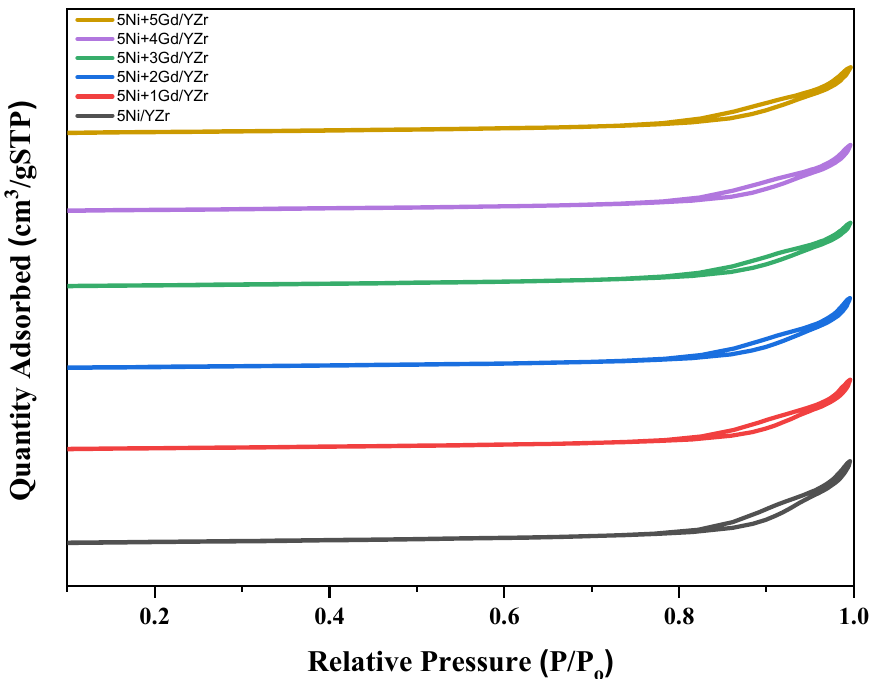
Table 1. Textural properties (S BET , P v , and P d ) of the fresh catalysts.